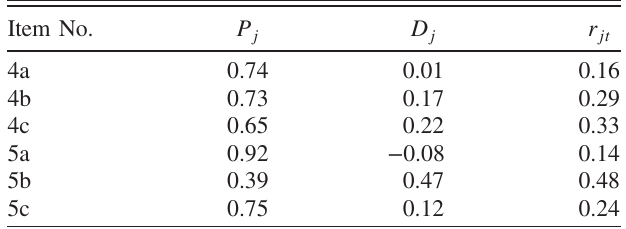
TABLE VIII. Item statistics: Item difficulty index P j , item discriminatory index D j , and item-test correlation coefficient r jt for items 4 and